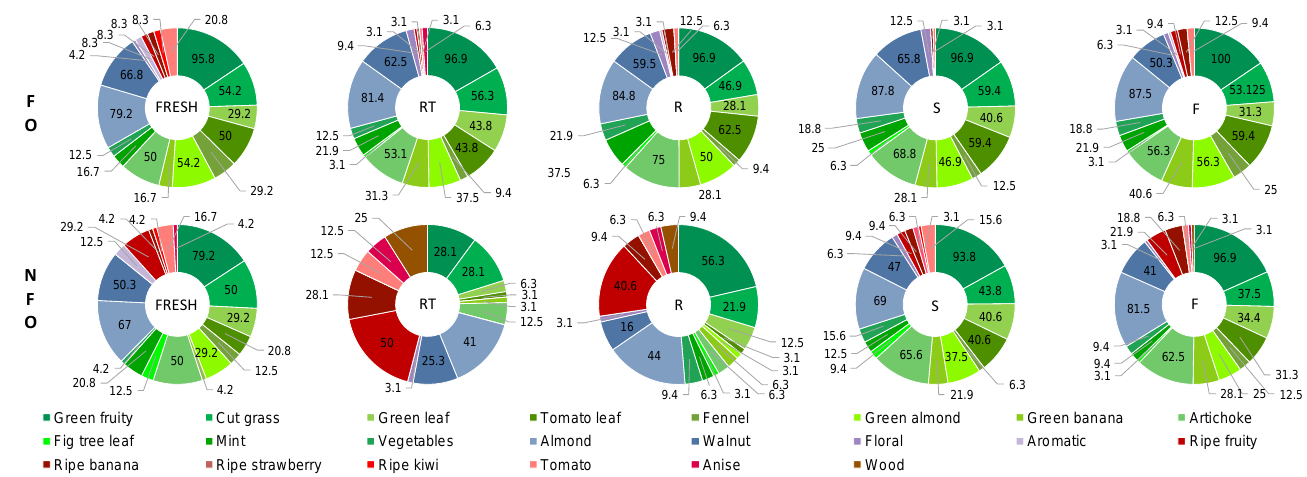
Figure 6. Full profile of secondary sensory attributes of the filtered (FO) and unfiltered (UO) oils at the beginning of the study (fresh) and after 24 months at room temperature (RT), 4 ◦ C (R), and at − 20 ◦ C (S, frozen at − 20 ◦ C; F, frozen with liquid nitrogen). Secondary sensory attributes are expressed as % of panelists perceiving the attribute. The green and the red color palette correspond to attributes associated with green and ripe notes,